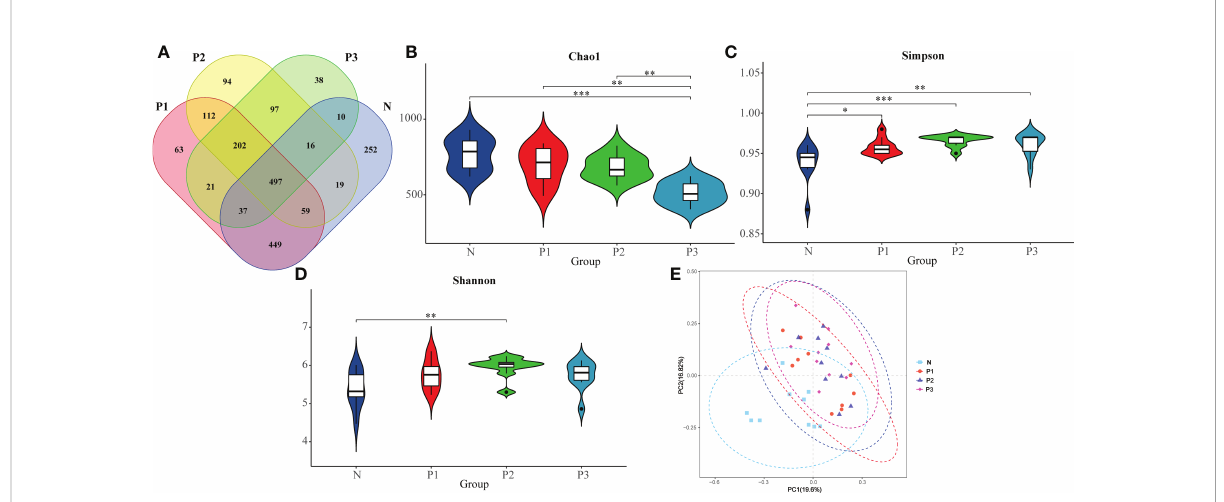
FIGURE 1 (A) Differences in number of OTUs among microbiota from N, P1, P2, and P3. (B) The comparison of Chao 1 index in N, P1, P2, and P3. (C) The comparison of Simpson index in N, P1, P2, and P3. (D) The comparison of Shannon index in N, P1, P2, and P3. (E) PCoA analysis revealing the bacterial communities in N, P1, P2, and P3. * P<0.05, ** P<0.01, ***